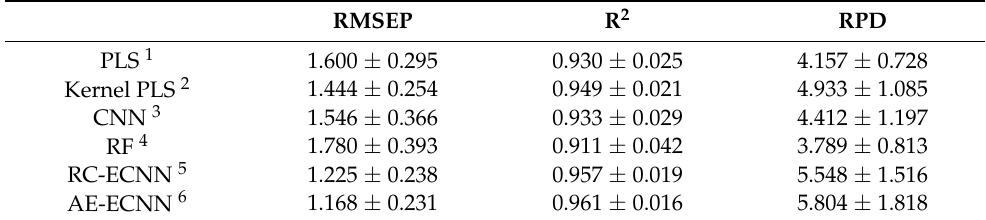
Table 2. Regression results of the hydrolyzed leather protein (HLP) data set obtained by the ensemble convolutional neural network based on attention mechanism (AM-ECNN) and the contrast methods. R 2